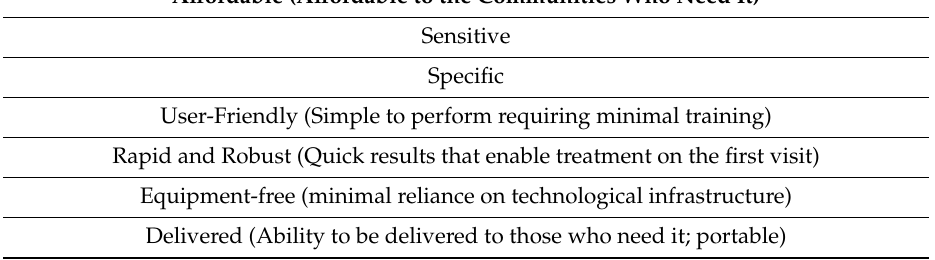
Table 1. WHO ASSURED Criteria.